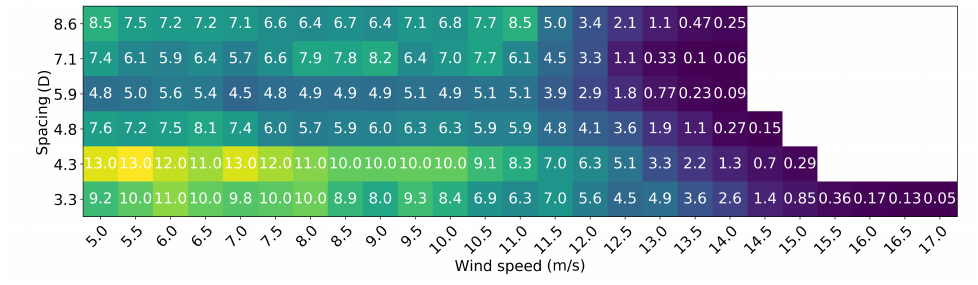
Figure 7. The different model parameters as a function of the wind speed, for a spacing of 4.8 D and θ ∞ = 180 ◦ . ( a ) corresponds to k a ( b ) to k b ( c ) to α ( d ) to β ( e ) to a d ( f ) to b d .